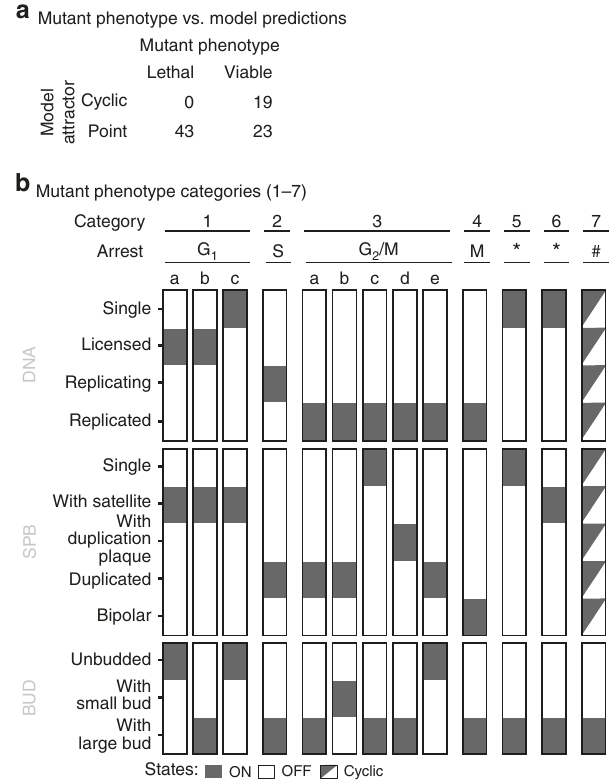
Fig. 5 The model predicts the phenotypes of a majority of all tested mutants. Simulations were performed by introducing deletions (setting all protein states (and mRNA and gene, if appropriate) to false), point mutations (by locking proteins in a certain modi fi cation state) or constitutive overexpression (by setting the transcription reaction to True constantly), and the mutants were analysed through simulation by release from the (modi fi ed) G 0 state of the wild-type. a The model predicts the correct phenotype (lethal or viable) for 62 out of 85 mutants, although closer inspection revealed that several of the 23 inconsistent mutants can be explained by implicit synthetic lethality or strong phenotypes (Table 2). b The 62 mutants that are predicted to be dead arrest at thirteen distinct arrest points, that correspond to G 1 (1a – c, 5*, 6*), S (2), G 2 /M (3a – e), M (4) and T (5*, 6*) arrest, or progress through a partial cyclic attractor with repeated DNA replication and nuclear division but no cell division, resulting in multinucleate cells. Note that group 5 and 6 contain both G 1 and T arrested cells. Both have completed DNA segregation and nuclear division, but T arrested cells fail to undergo cytokinesis and hence arrest with two nuclei. The cells in groups 5 and 6 can only be distinguished on the DNA/ nuclei count (Supplementary Table